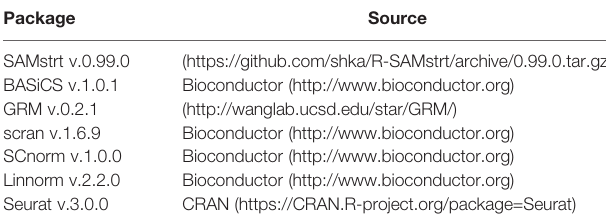
TABLE 3 | A list of source packages for downloading.